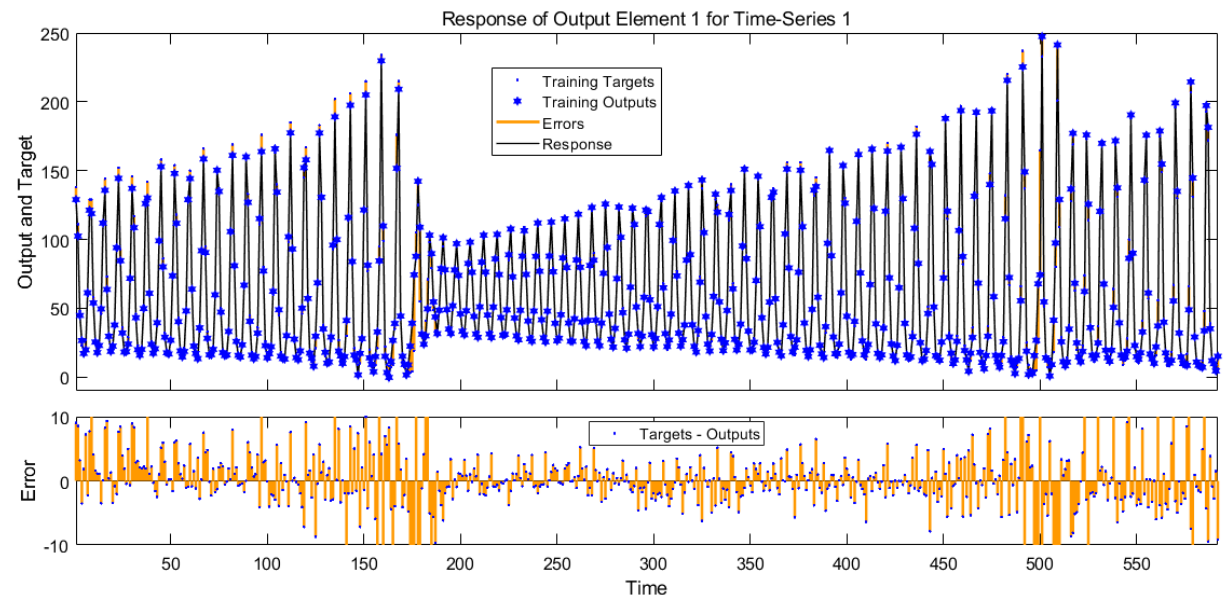
Figure 9. Time series response of training the created HNN